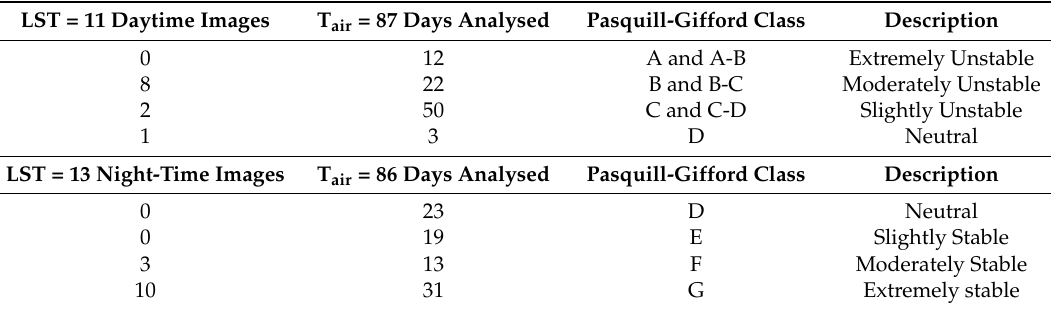
Table 4. Pasquill-Gifford